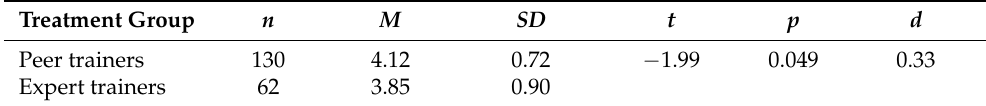
Table 6. Independent t-test for T102 pretest perception of historical trauma’s meaning.